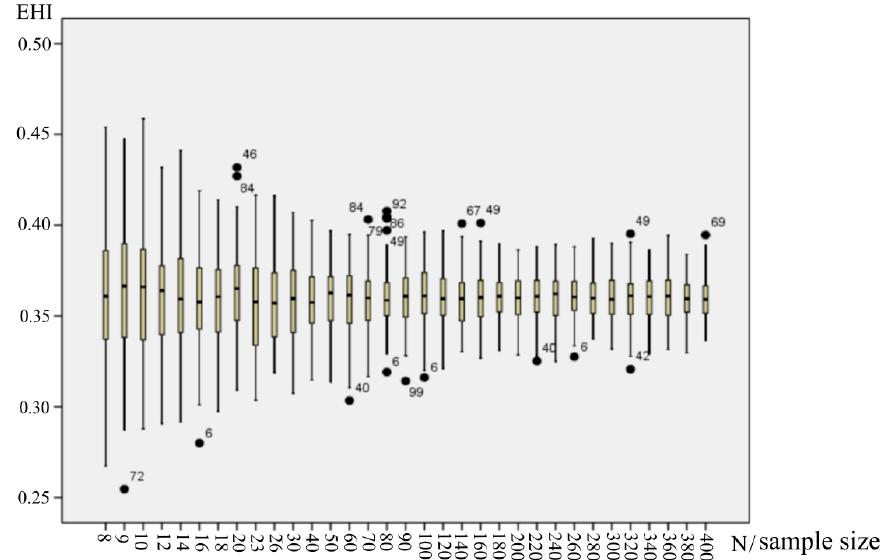
Figure 3. The box-plots of the ecosystem health index (EHI) based on Monte Carlo simulation. (1) Each box-plot represents the dispersion of 100 EHI values obtained in 100 times simulation of a specific sample size (N); (2) the black dots represent the outliers; the number next to the black dots represents the ordinals of 100 times simulation. Table 2. The Pressure-State-Response (PSR) framework and the weight of each indictor.